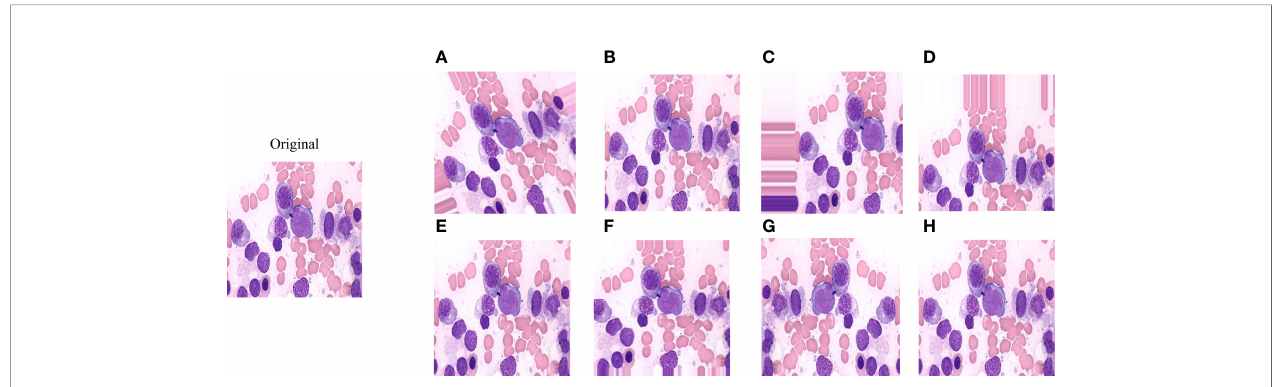
FIGURE 2 | The effect of applying image transformation to the same image sample. (A) rotation; (B) ZCA whitening; (C) width shift; (D) height shift; (E) shearing; (F) zoom; (G) horizontal fl ip; (H) vertical fl ip.